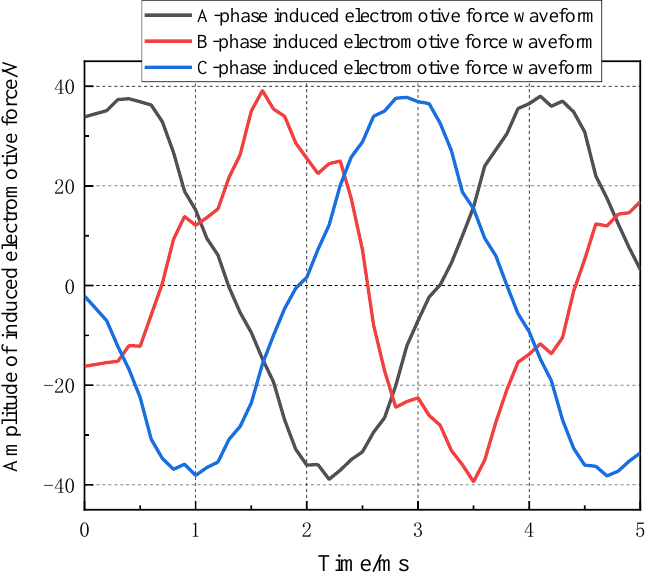
Figure 9. Three-phase no-load induction electromotive force waveform 3 Structure optimization.